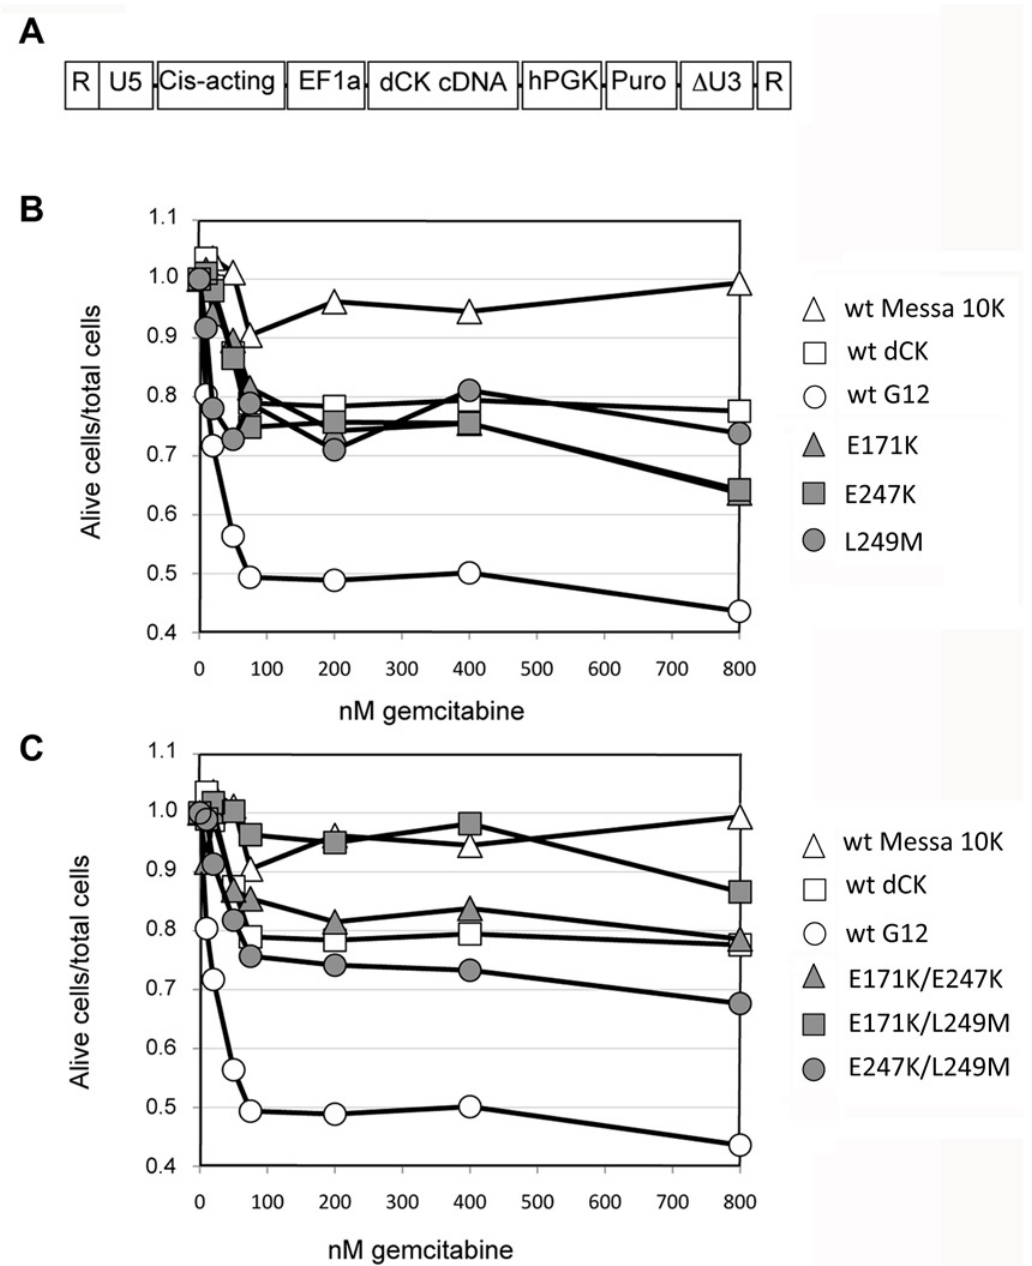
Fig 1. Contribution of the individual mutations of G12 to the observed phenotype. Panel A. Structure of the genomic RNA generated by transcription after transfection of cells with pSDY-SIN plasmids. R, repeated sequence from HIV-1 genome; U5, 5' unique sequence of HIV-1 LTR; Cis-acting, sequences required for packaging and reverse transcription of the genomic RNA; EF1-alpha, human elongation factor 1-alpha promoter; hPGK, human phosphoglycerate kinase promoter; Puro, puromycin N-acetyl-transferase gene; Δ U3, partially deleted version of the 3' unique sequence of HIV-1 LTR. Panels B and C. The proportion of alive cells over the total number of cells as function of the concentration in gemcitabine is given as a ratio with respect to the alive cells observed in the absence of drug. White symbols represent reference populations in both panels and. grey symbols represent single and double mutants (as described in the main text). Since single and double mutants were tested in parallel in the same experiment. The data are the average of 3 independent experiments. Error bars are not shown for the sake of